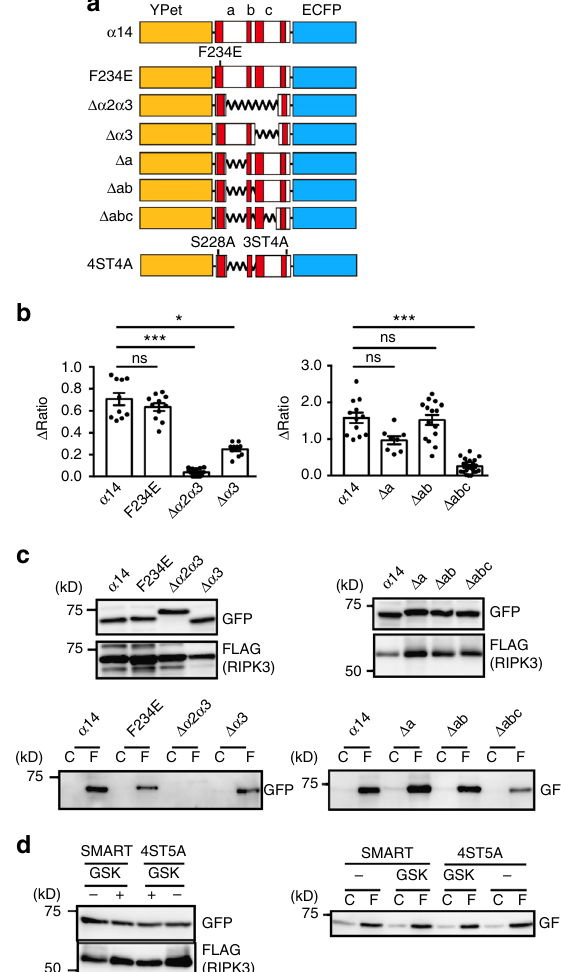
Fig. 2 Interaction of α 14 with RIPK3 is required for monitoring necroptosis. a Diagram of a series of α 14 mutants. F234E; phenylalanine at 234 is substituted with glutamic acid, 4ST5A; S228, S345, T347, S349, and S352 were substituted with alanines. Zigzag lines indicate the regions that were replaced with SAGG repeats. Red boxes indicate each α helix. b L929 cells were transiently transfected with the indicated mutants and then stimulated with TZ, and the FRET/CFP ratio was analyzed as in Fig. 1b. Maximum changes of the FRET/CFP ratio. Each dot indicates individual cell ( n = 10 – 14 cells). Statistical signi fi cance was determined using the one-way were transiently transfected with the indicated mutants along with FLAG- RIPK3. Cell lysates were immunoprecipitated and analyzed as in Fig. 1c. Results are representative of two independent experiments. d GSK ’